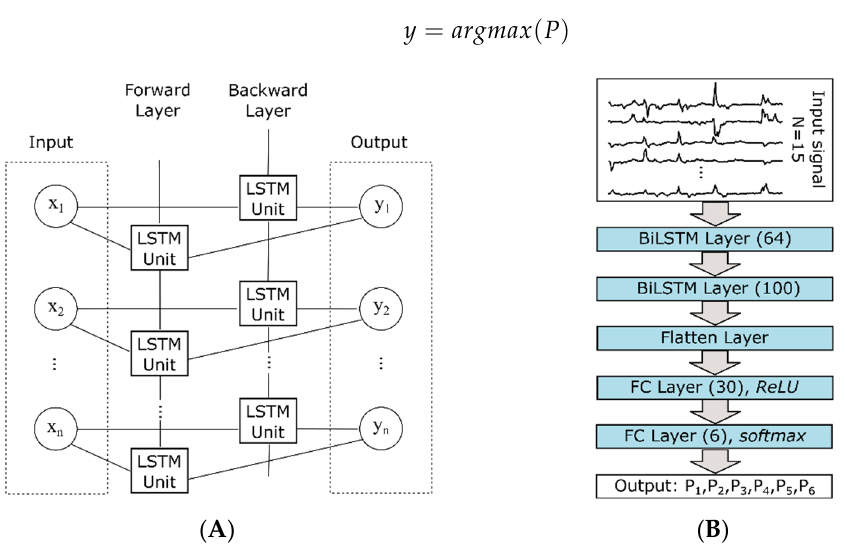
Figure 3. The architecture of the neural network. ( A ) shows the model of a BiLSTM layer with n hidden units. ( B ) shows the layers that were used to train the RNN. Numbers in parentheses indicate the number of hidden units.